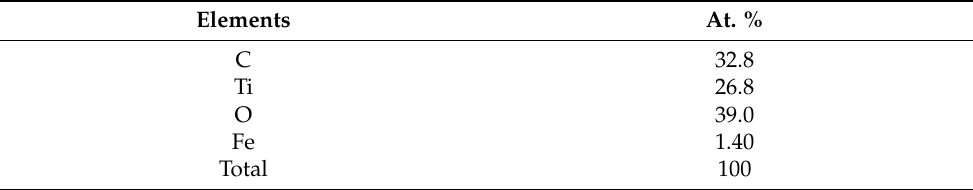
Table 2. EDS chemical analysis of the 5 mol% Fe-TiO 2 nanopowders after impregnation on the porous substrate. Elements At. %